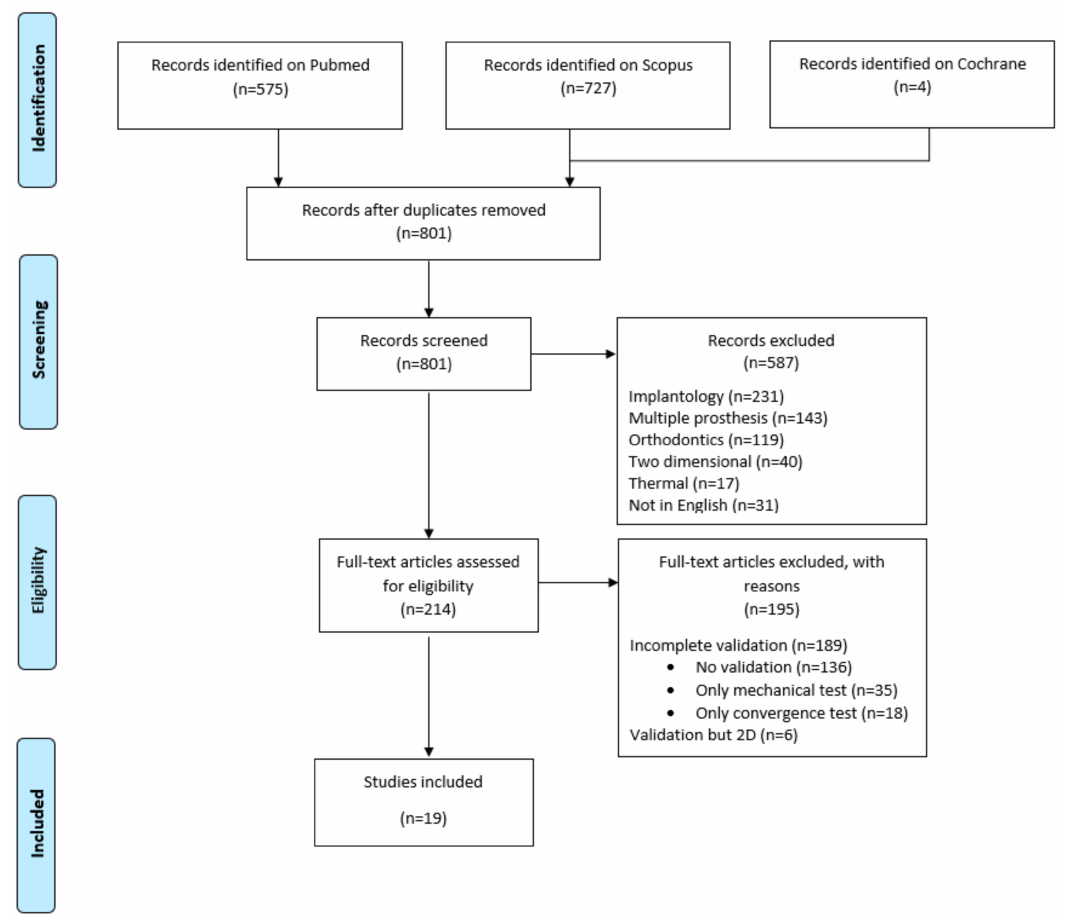
Figure 1. Flow diagram of the screening and selection process adapted from the Preferred Reporting Items for Systematic Reviews and Meta-Analyses (PRISMA) statement